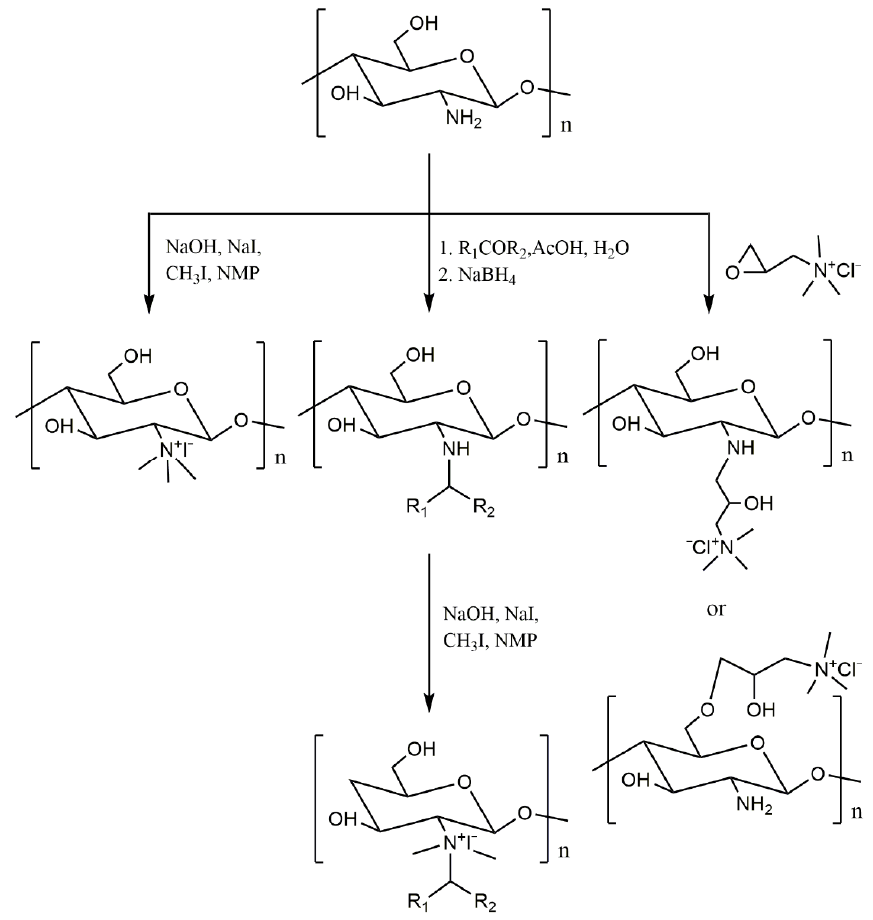
Figure 2. Three synthetic routes for quaternary ammonium salt of chitosan.